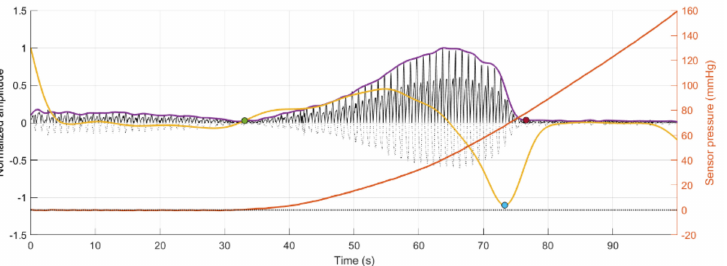
Figure 5. Segmentation of the area of interest for analysis, which is enclosed between the green and red circles, for each of the replicas of signals obtained from red (R) and infrared (IR) PPG signals. Dotted signal: Original PPG signal. Black signal: Rectified PPG signal. Purple line: Envelope of the rectified PPG signal. Yellow line: First derivative of the envelope signal. Blue circle: Minimum point of the first derivative signal. Orange line: Sensor pressure.